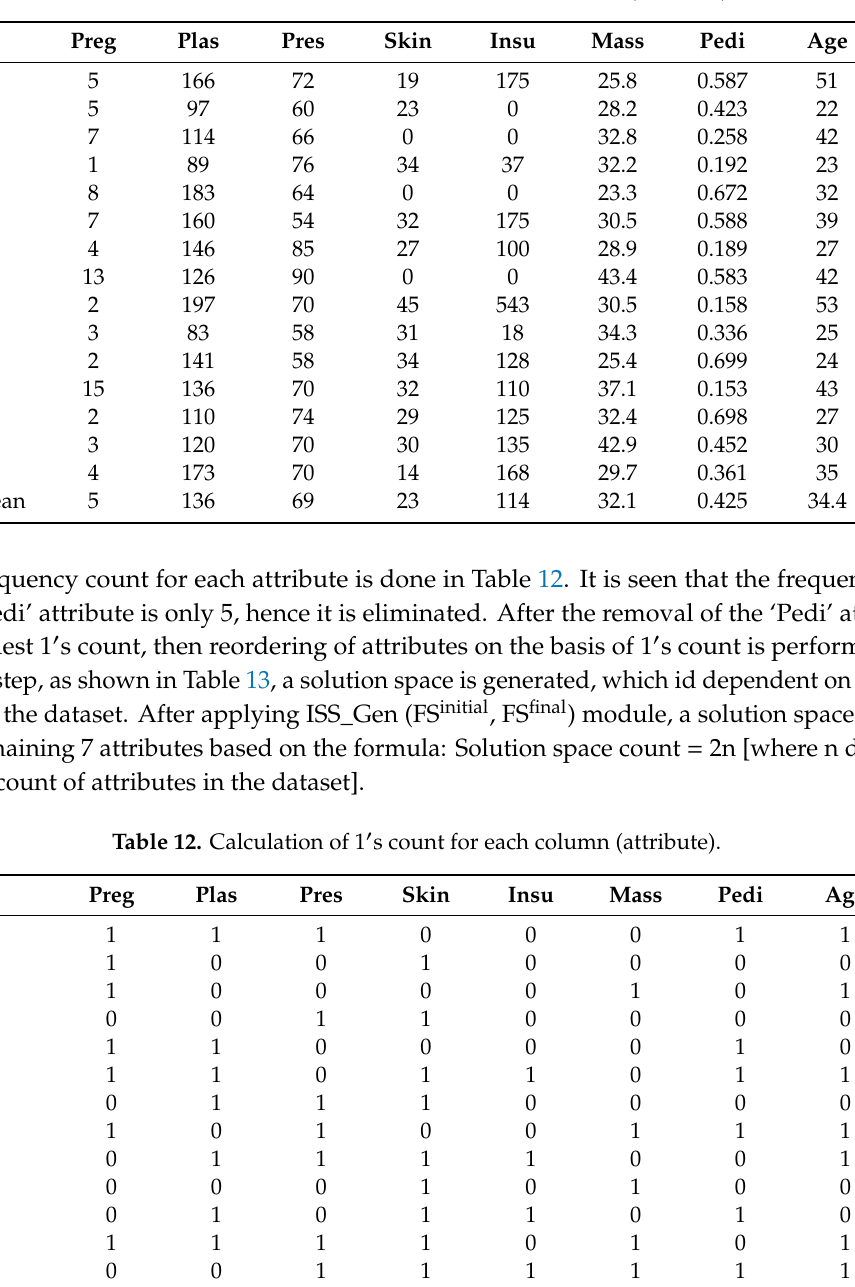
Table 11. Calculation of Mean value for each column (attribute).